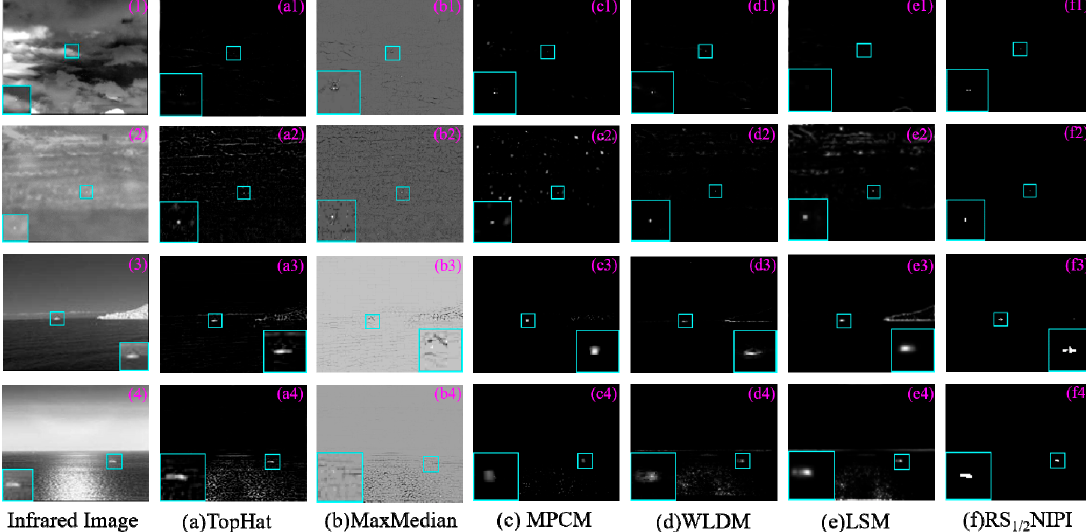
Figure 11. Representative single target images from the datasets and the target images obtained by saliency-based methods and the proposed one. ( 1 )–( 4 ) are four representative single target images from the tested datasets.